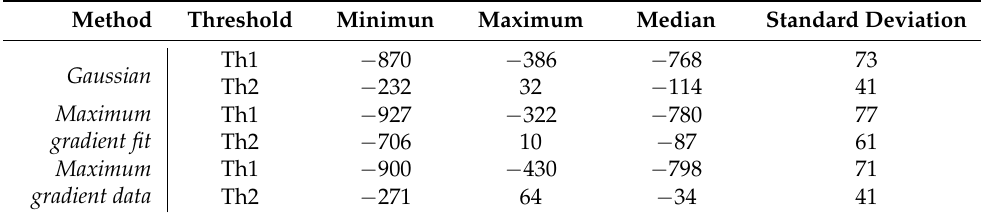
Table 3. Summary table of the threshold values found with the methods used.